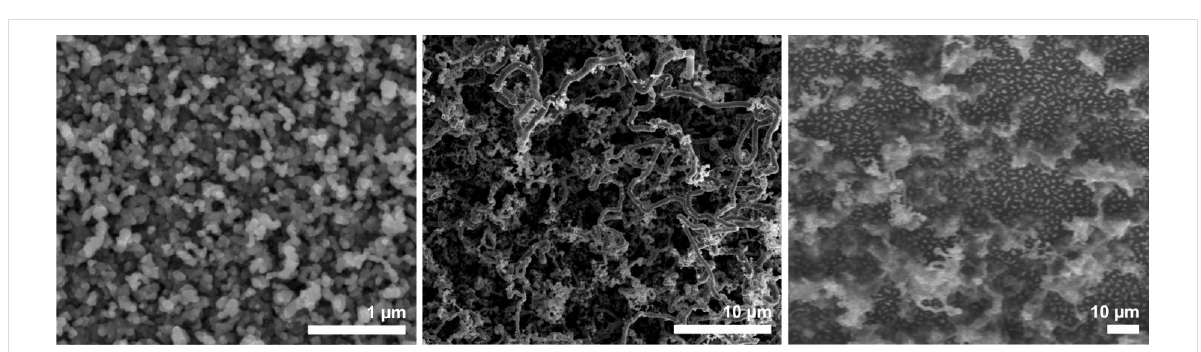
Figure 7: SEM image of NWs grown at 375 °C for 1 h, on annealed gold films of different sputtering times (left: sample 1b; center: sample 2b; right: sample 3b).